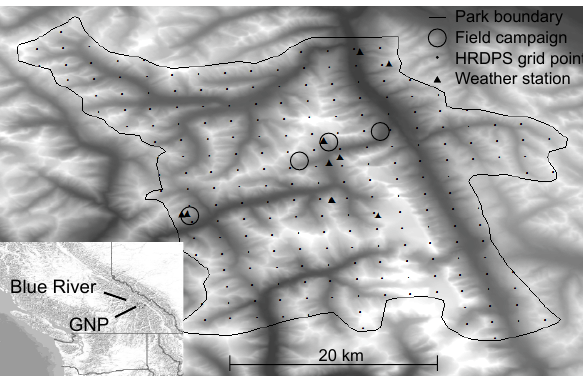
Figure 1. Map of Glacier National Park (GNP) with the locations of field campaigns, High-Resolution Deterministic Prediction Sys- tem (HRDPS) grid points, and weather stations (30m digital eleva- tion model basemap from DMTI Spatial). Inset map shows south- western Canada and the location of GNP and Blue